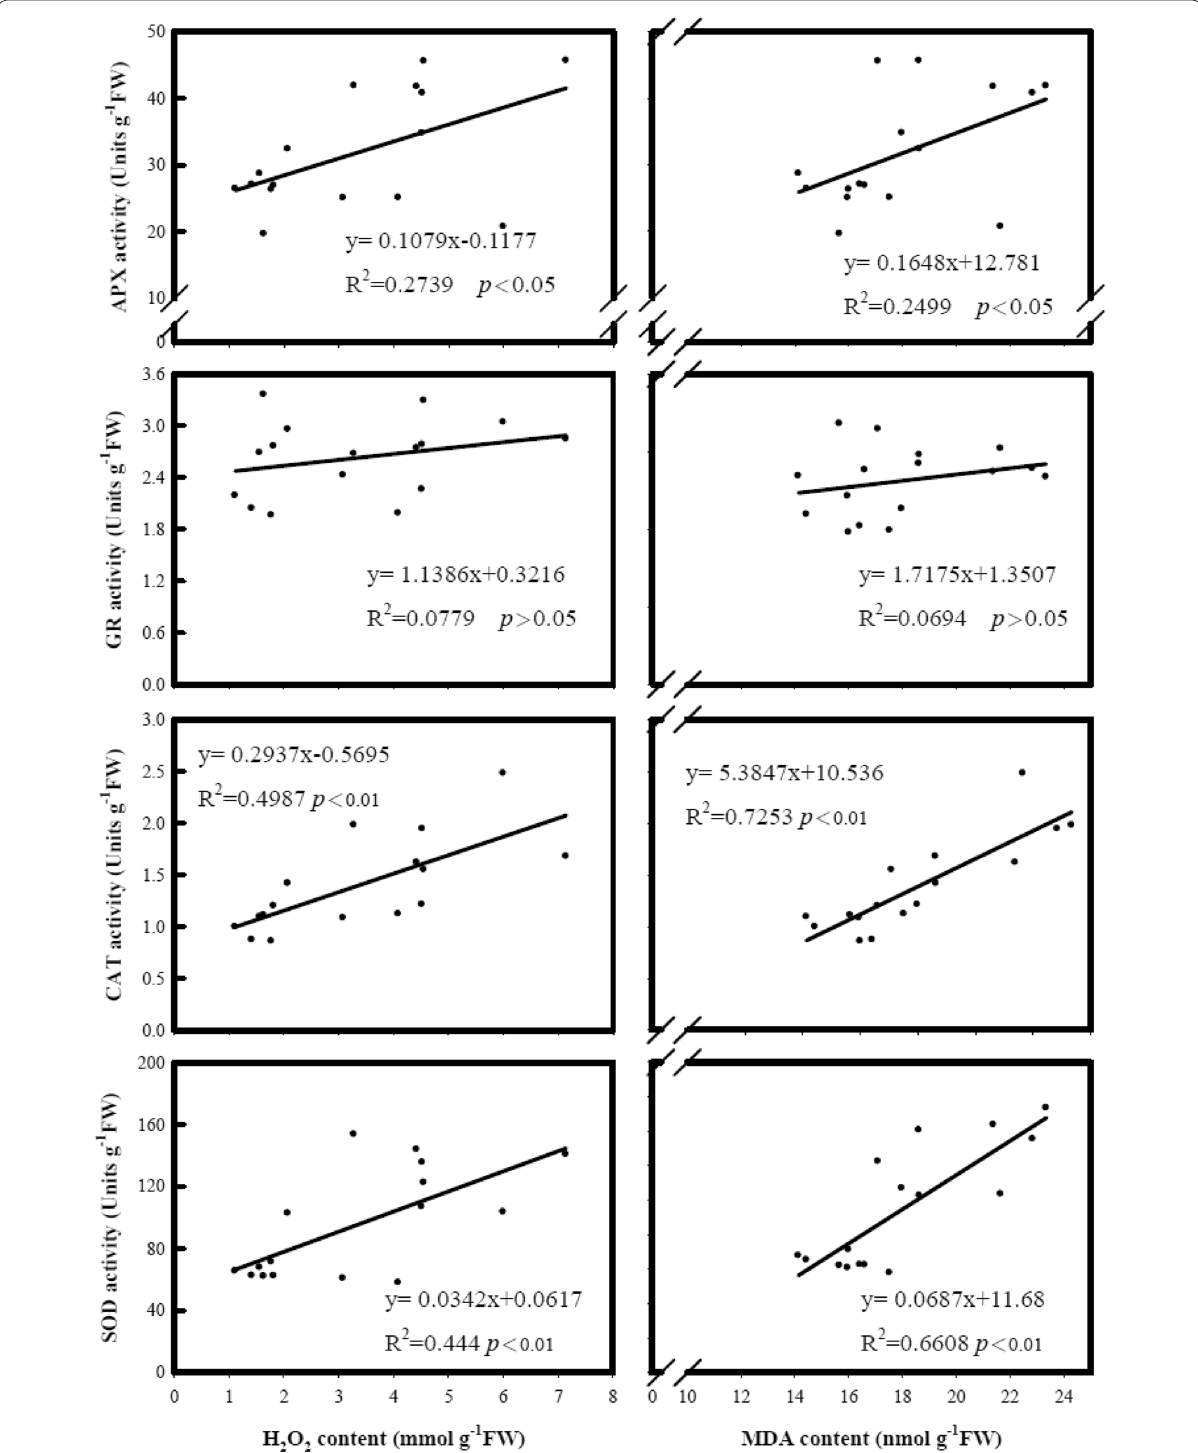
Fig. 6 The relationships of root H 2 O 2 and MDA contents with root superoxide dismutase (SOD), catalase (CAT), ascorbic peroxidase (APX), glutathione reductase (GR) activities under cold treatment among eight cultivars. The temperature was set at 15 °C for cold treatment and 27 °C for control. After 4 days of treatment, the temperature was adjusted to 27 °C for 3 days before